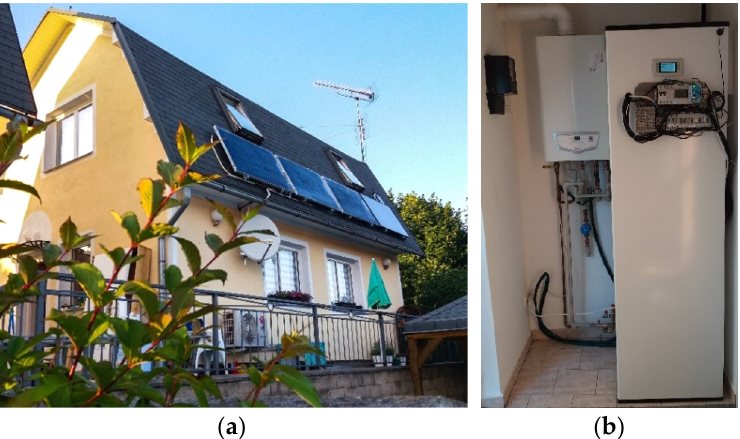
Figure 4. The single-family house after the intervention: ( a ) Outdoor view with the PVT/PV units installed and under operation; ( b ) Indoor room with the HP, TES and monitoring instrumentation.